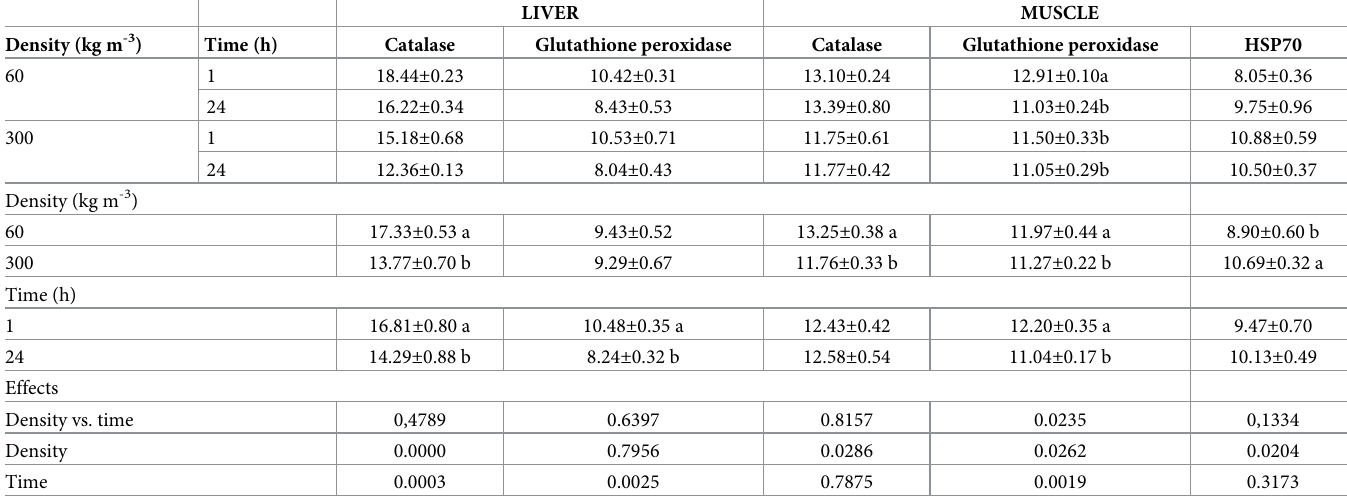
Table 2. mRNA expression of antioxidant enzymes in Nile tilapia subjected to different densities (60 and 300 kg m -3 ) and depuration times (1 and 24 hours).